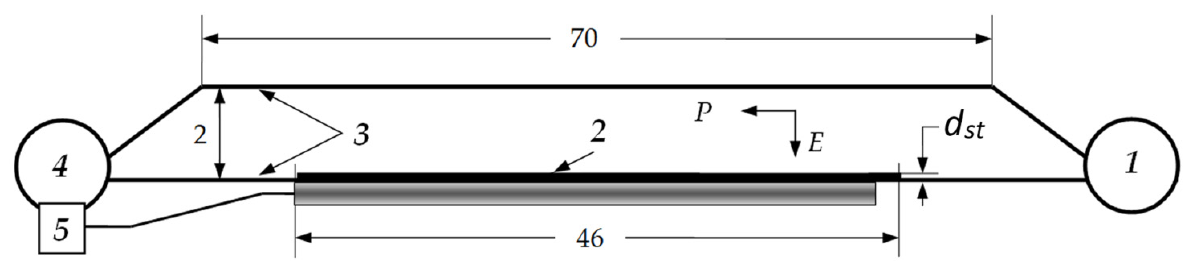
Figure 8. A scheme of the TEM gauge line cell. 1 = generator of step-like pulses; 2 = strip-line sensor; 3 = base and signal electrodes; 4 = resistor load; 5 = oscilloscope.